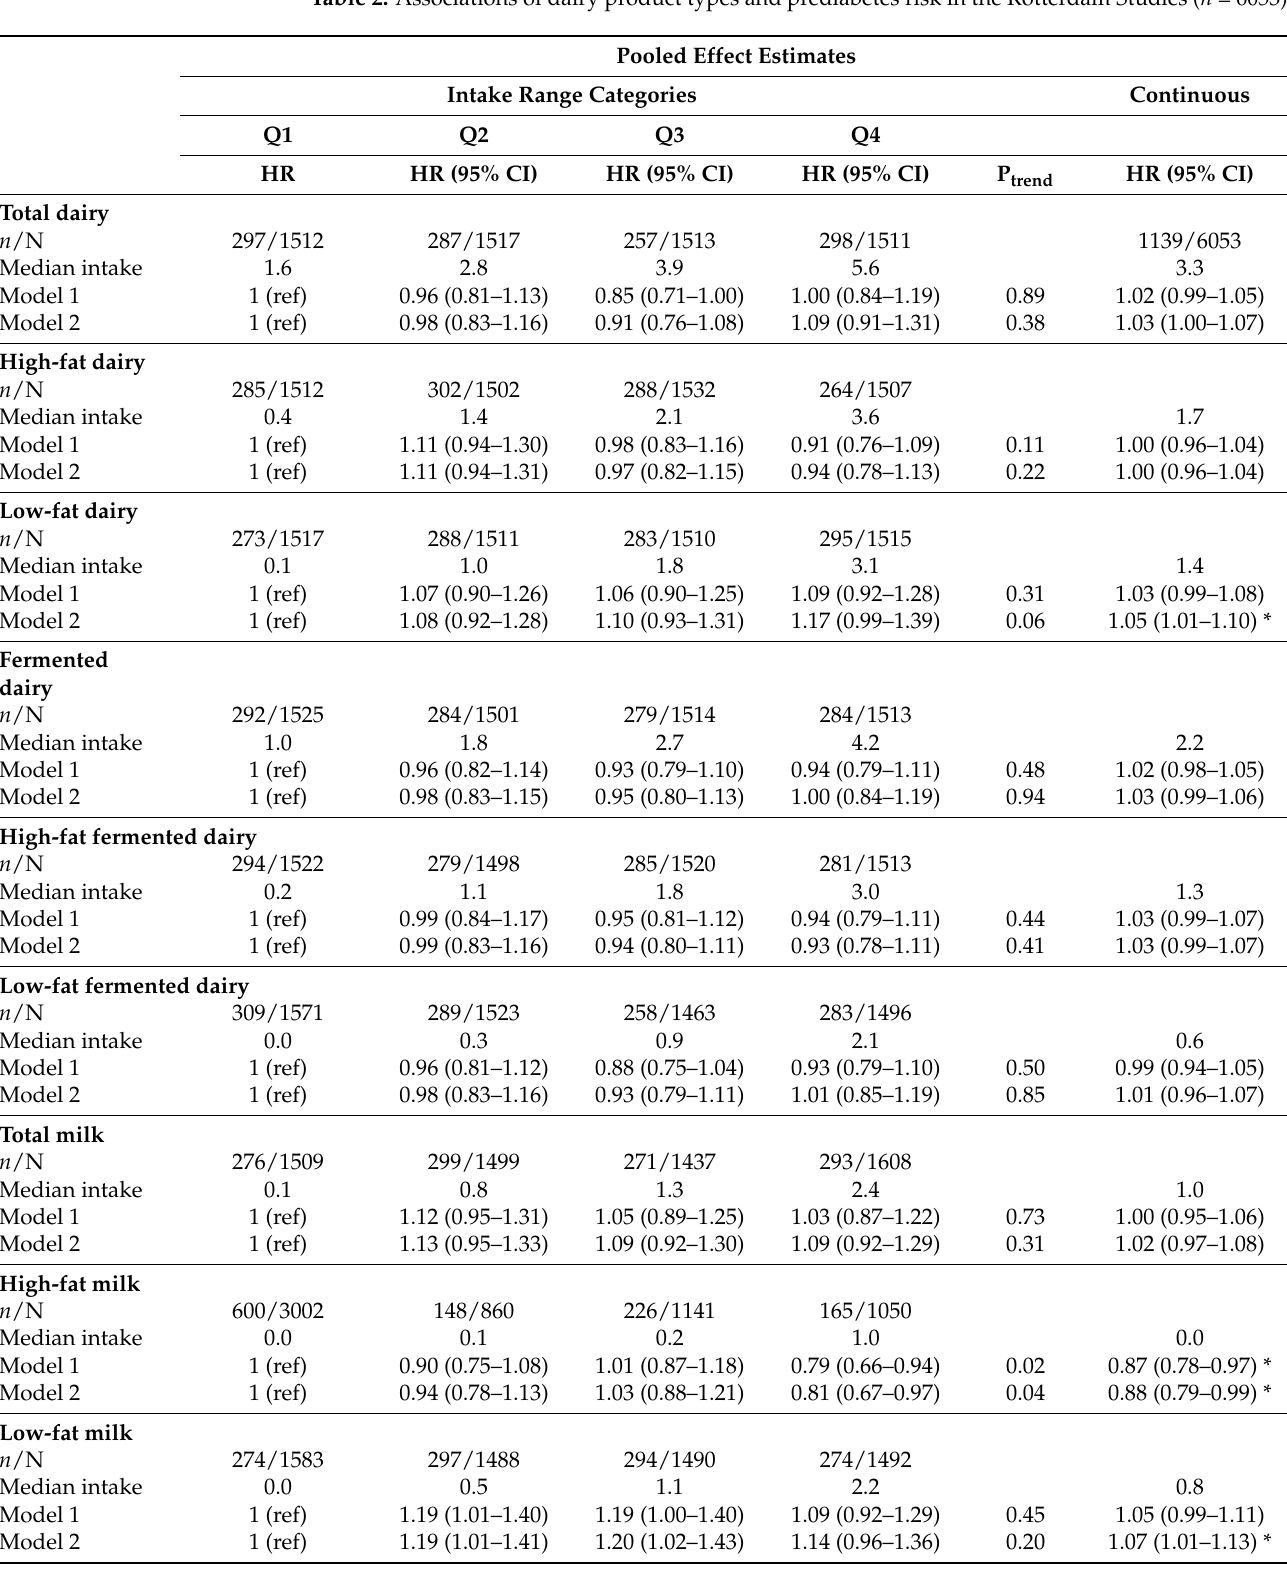
Table 2. Associations of dairy product types and prediabetes risk in the Rotterdam Studies ( n =